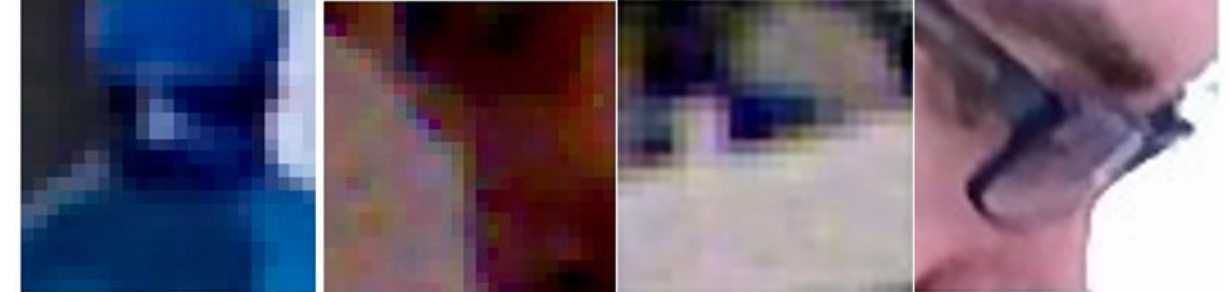
Figure 4. Examples of images rejected by the filtering methods.